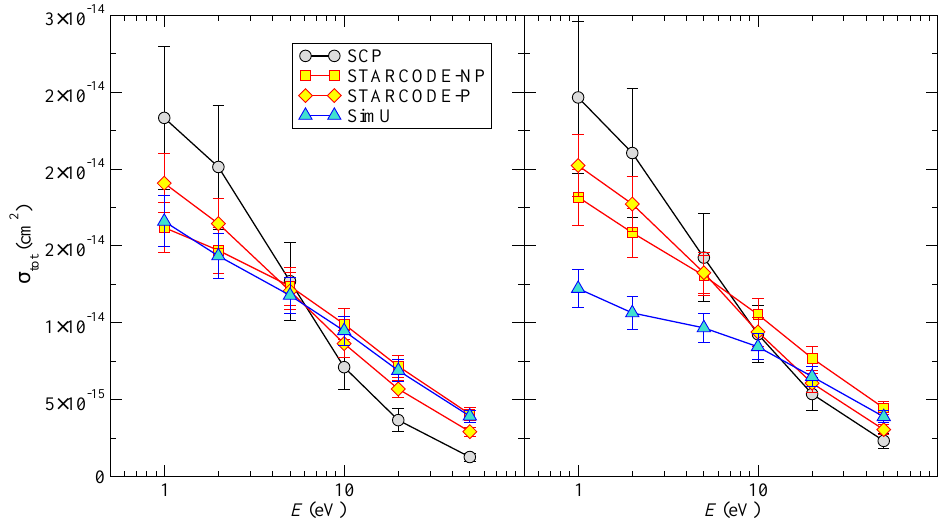
Figure 4. Li I 2 s − 2 p total cross-section as a function of the energy E . ( Left ) the dipole interaction is only taken into account; ( Right ) the dipole and quadrupole interaction are both taken into account.